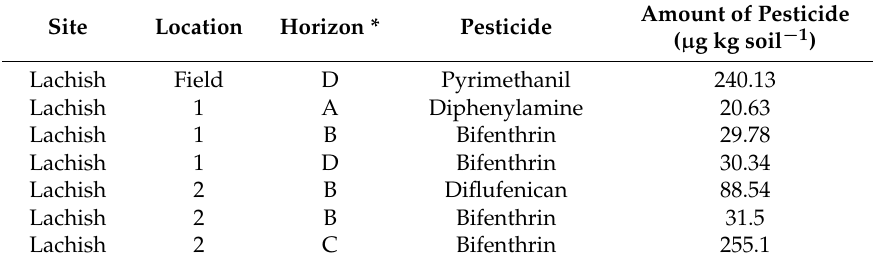
Amount of Pesticide ( µ g kg soil − 1 )